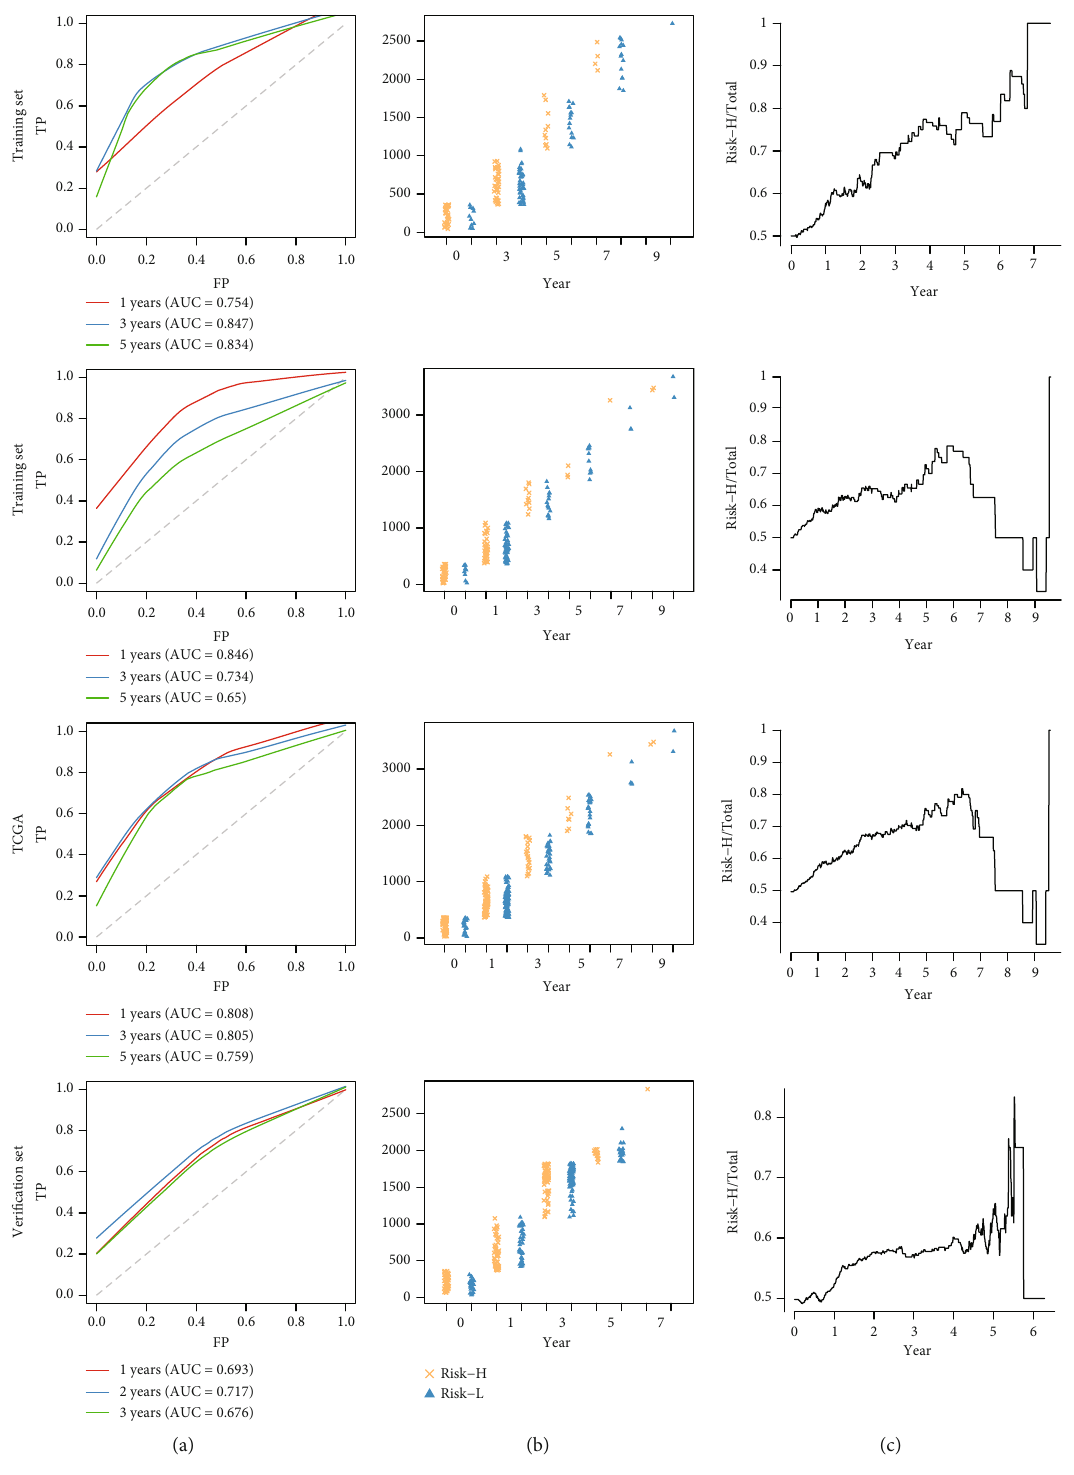
Figure 2: Prognostic analysis of the nine-IRGP signature. (a) Time-dependent ROC curve analysis of the nine-IRGP signature based on training, testing, TCGA, and veri fi cation sets. (b) Statistics of high- and low-risk groups under di ff erent over survival based on the training, testing, TCGA, and veri fi cation sets. (c) The proportion of the high-risk group in the total samples changed with over survival time in the training, testing, TCGA, and veri fi cation